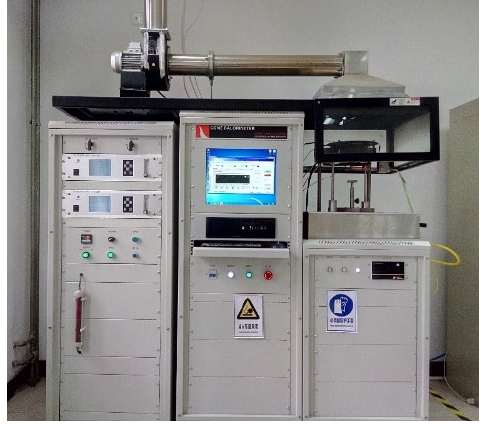
Figure 3. Cone calorimeter.